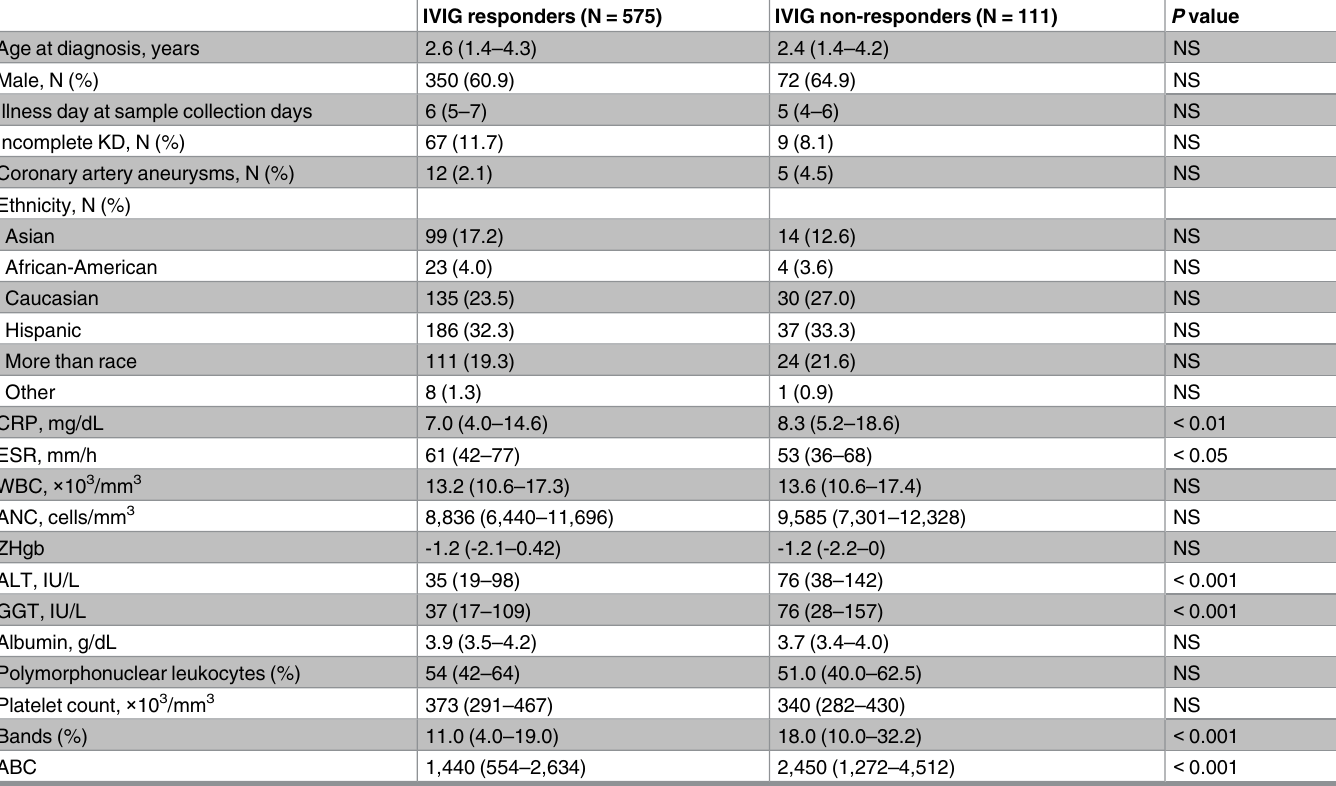
Table 1. Clinical and laboratory characteristics values of 686 IVIG responsive and resistant KD